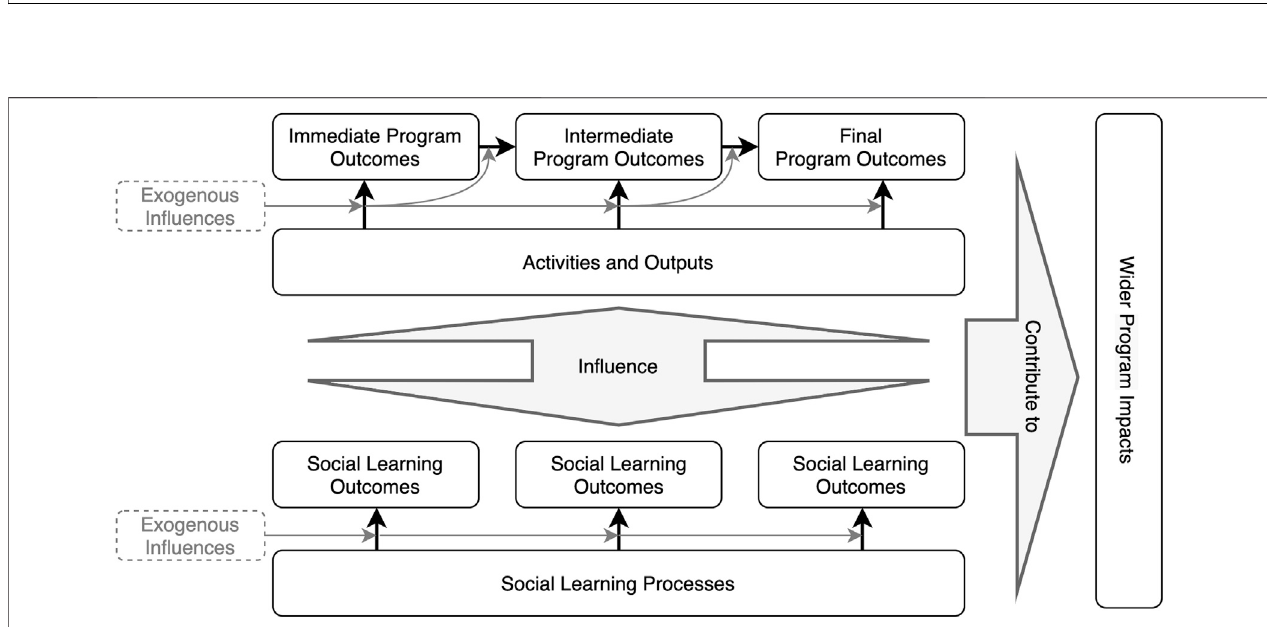
FIGURE3| Atwo-layered contributionpathwaycapturingsociallearningdynamics. Figure3 illustratestheconceptualmodeloftheproposedmethod.Itsplitsthe contribution pathway into a program implementation layer and a learning-focused layer to outline the change process.